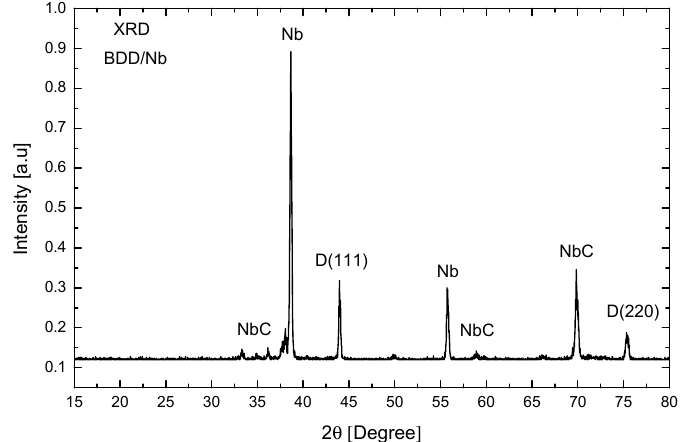
Figure 3. The X-ray di ff raction (XRD) patterns of BDD / Nb electrodes (thin film of boron doped diamond (BDD) coated on Nb mesh substrate.